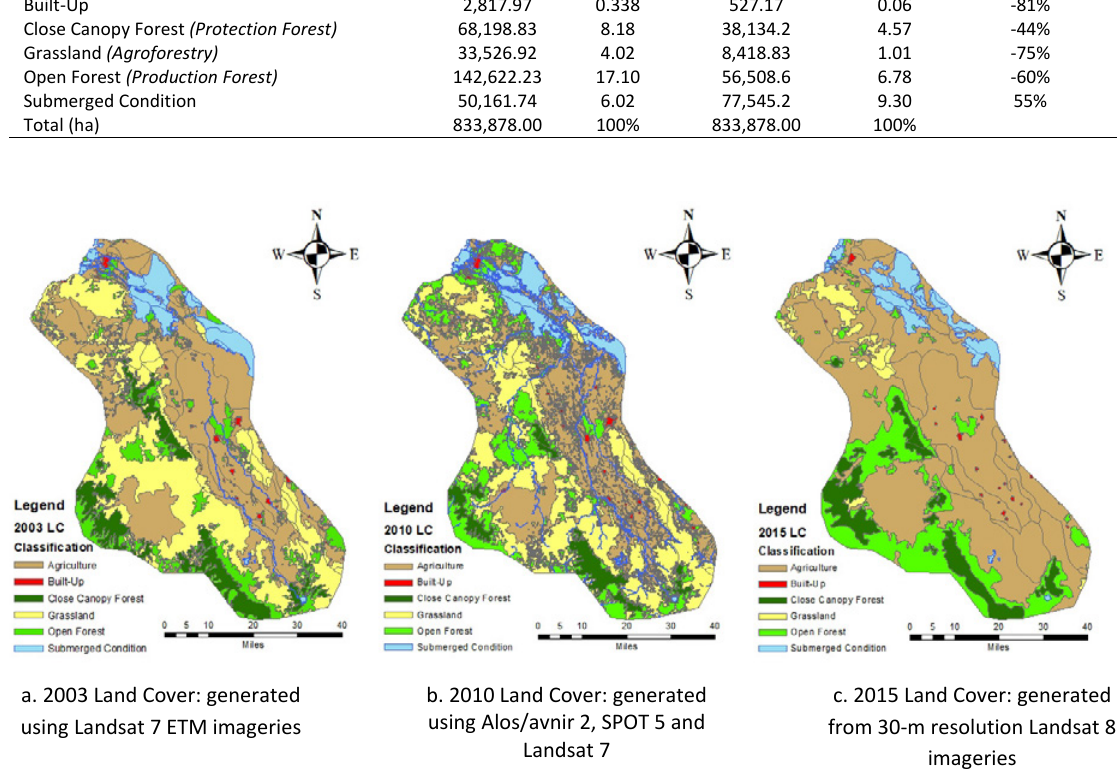
Fig. 4: a) 2003 land cover; b) 2010 land cover; and c) 2015 land